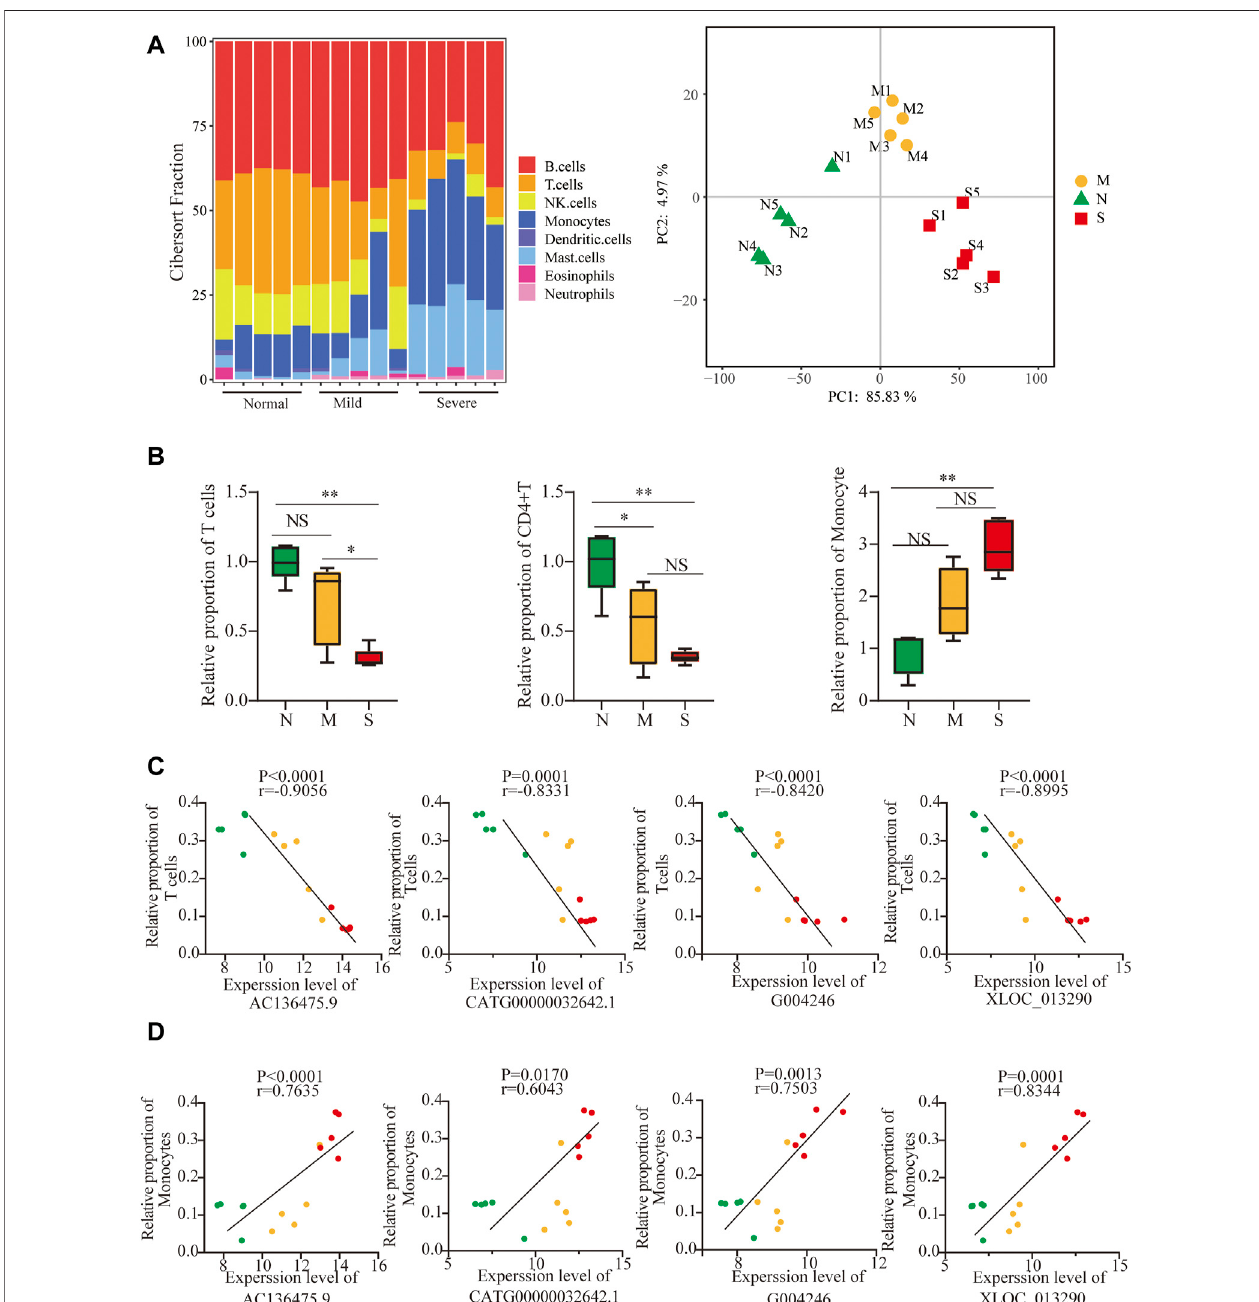
FIGURE 5 | Validation of lncRNAs as biomarkers by differences in immune cell compositions. (A) Pro fi les of immune subtypes are shown using bar plots; PCA between normal and COVID-19. (B) Difference in immune subtypes among three groups is shown using the Mann – Whitney test, including T cells, CD4+ T cells, and monocytes. (C,D) Correlationbetween4lncRNAsandTcellsandmonocytesinnormal,mild,andseveregroups.Thenormal,mild,andseverepatientswerecoloredby green, yellow, and red dots, respectively. ns: non-signi fi cant; * p < 0.05; ** p < 0.01.